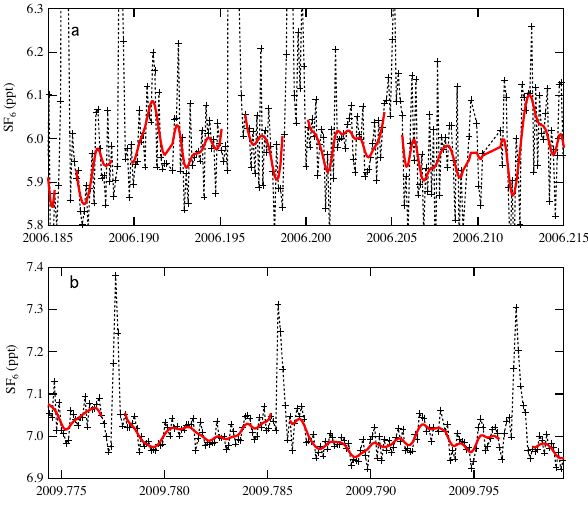
Fig. 6. Time series of SF 6 at Niwot Ridge, Colorado showing base- Figure 6: Time series of SF 6 at Niwot Ridge, Colorado showing baseline conditions and 546 line conditions and pollution events during two periods: (a) prior to pollution events during two periods: (a) prior to GC modification; (b) following GC 547 GC modification; (b) following GC modification. Both panels show modification. Both panels show a smooth fit to baseline data (approximate) (red lines). 548 a smooth fit to baseline data (approximate) (red lines).